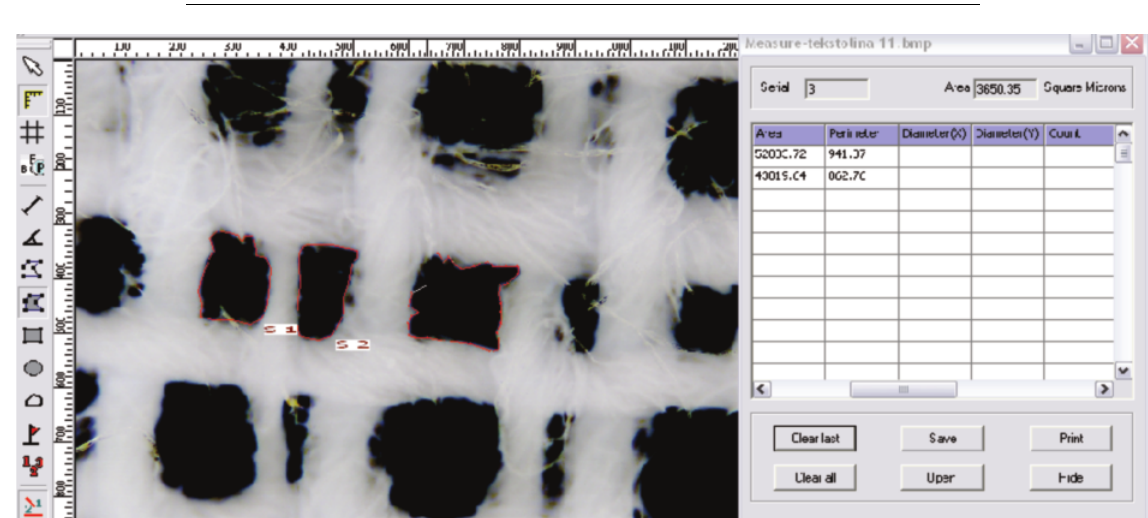
Figure 4. Microscopic image of Sample 8 and the measurement of the pore area.